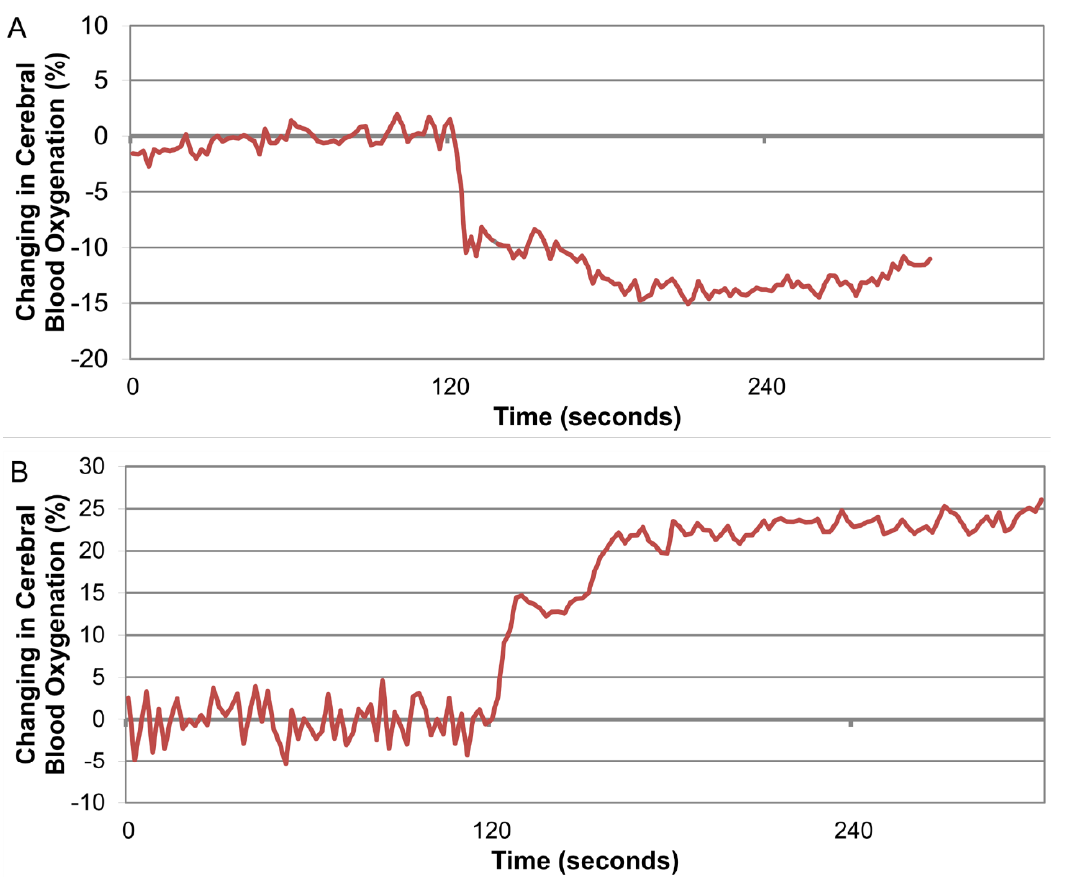
Figure 1. Fluctuations in cerebral blood flow in the supine position (0–120 s) followed by the standing position. ( A ) Cerebral blood flow was increased upon standing. ( B ) Cerebral blood flow was decreased upon standing.